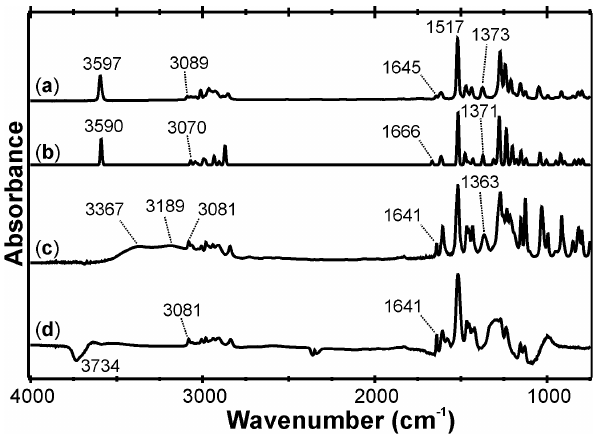
Fig. 2. (a) Experimental and (b) computational spectra of gaseous eugenol. DRIFTS spectra of eugenol adsorbed on (c) NaCl and (d) α -Al 2 O 3